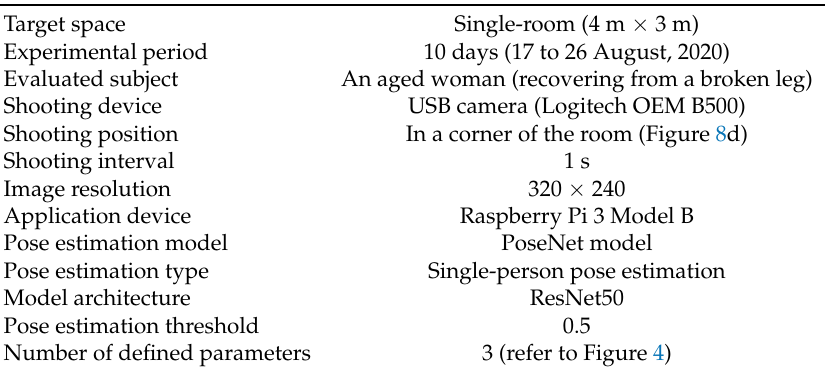
Table 3. Environment and application